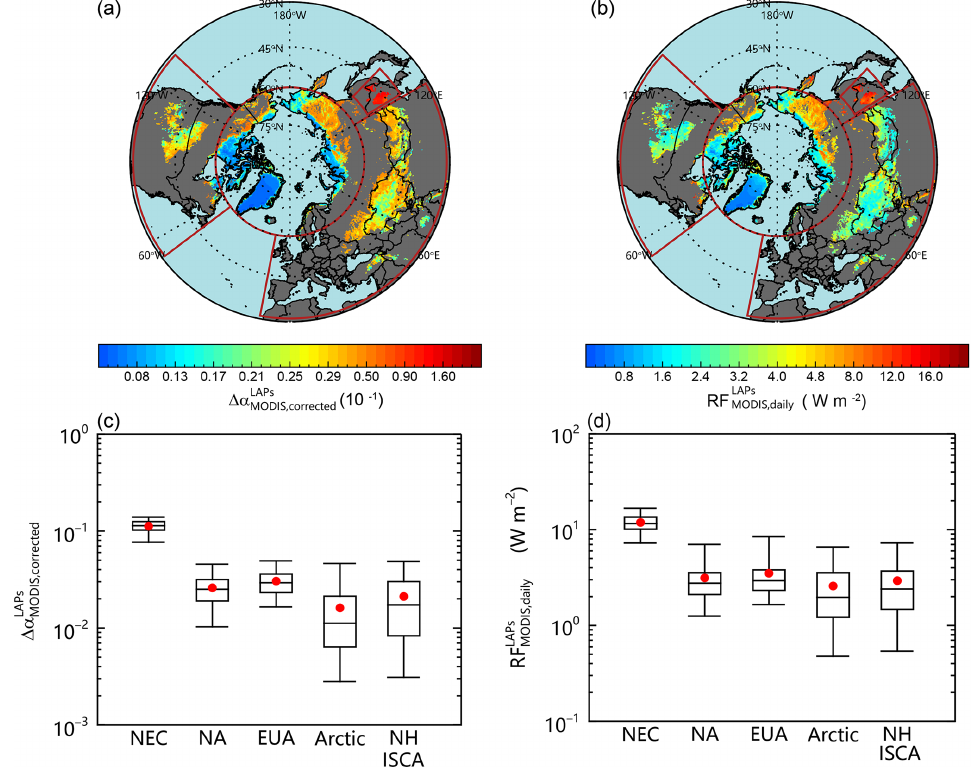
Figure 6. Spatial distributions of averaged (a) (cid:49)α LAPs and (b) RF LAPs and statistics for regionally averaged MODIS,corrected MODIS,daily (c) (cid:49)α LAPs and (d) RF LAPs for the Northern Hemisphere ISCA in December–May during the period 2003–2018. The MODIS,corrected MODIS,daily boxes denote the 25th and 75th quantiles, and the horizontal lines represent the 50th quantiles (medians); the averages are shown as red dots; the whiskers denote the 5th and 95th